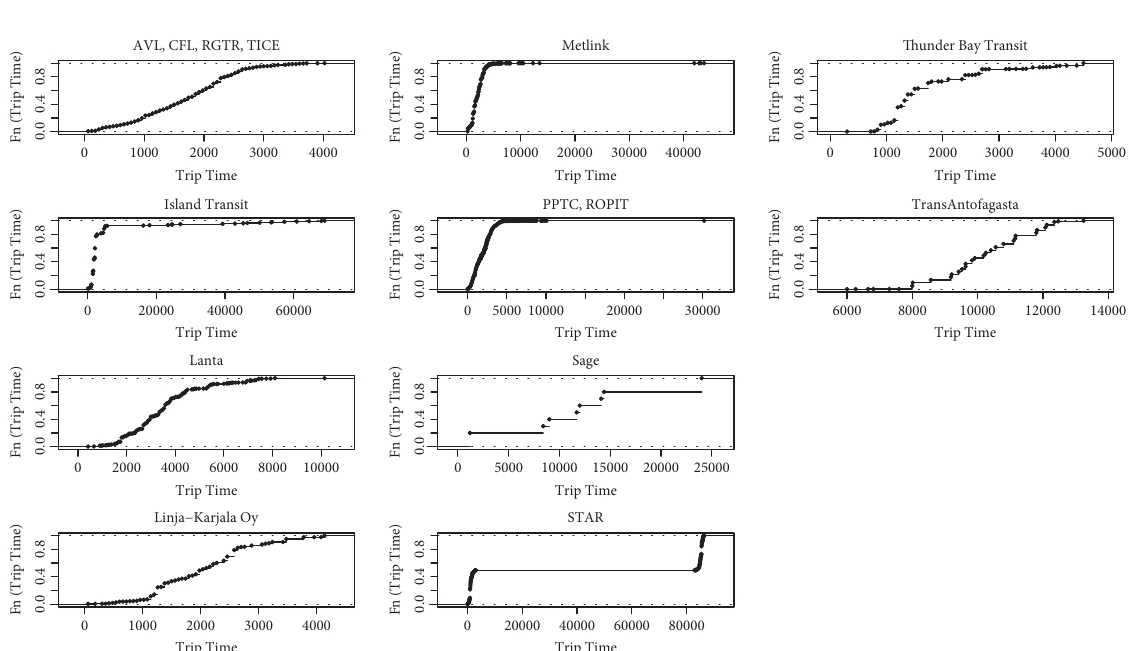
Figure 2: Cumulative probability distribution of trip